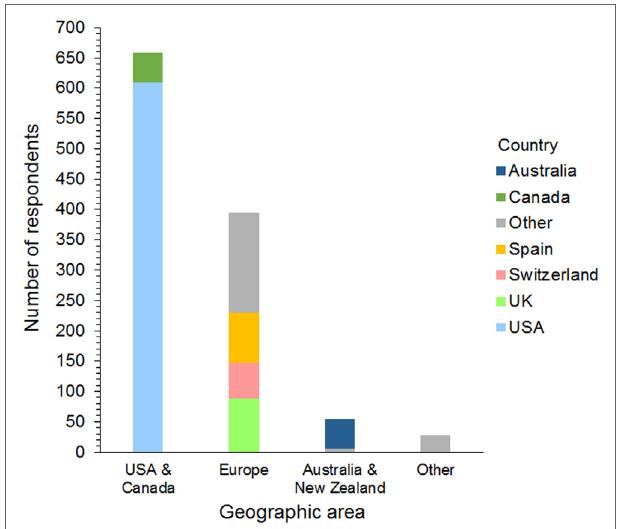
FigUre 1 | Frequency chart showing the geographic distribution of the 1,134 survey respondents. Countries represented by 30 or more respondents are shown separately within each geographic area.